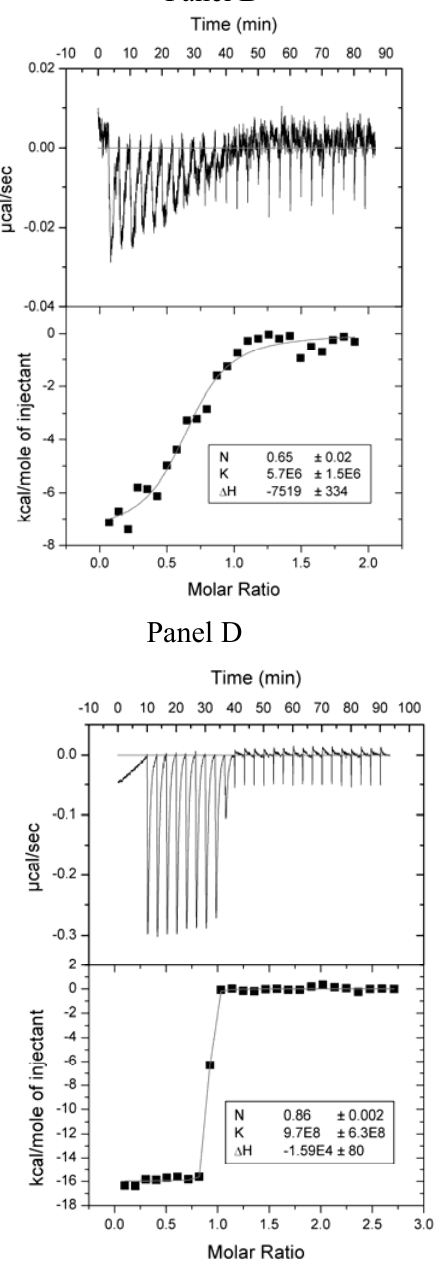
Figure 1. Panel A. Isothermal titration calorimetry data from radicicol binding to Hsp90 α N. Upper graph – raw ITC data, lower graph – integrated ITC data with the curve fit to the standard single binding site model. The cell contained 4 µM protein, while the syringe contained 40 µM radicicol in the same buffer - 50 mM sodium phosphate, pH 7.5, 0.5% DMSO, 100 mM NaCl, at 25 °C. Panel B. Isothermal titration calorimetry displacement assay. All conditions are the same as in Panel A, except there was 1 mM compound 1 added to the calorimeter cell. Panel C. Chemical structures of radicicol and compound 1. Panel D. Isothermal titration calorimetry data from ethoxzolamide binding to hCAII. The cell contained 7 µM protein, while the syringe contained 100 µM ethoxzolamide in the same buffer - 50 mM sodium phosphate, pH 7.0, 0.5% DMSO, 50 mM NaCl, at 37 °C. Panel A Panel B